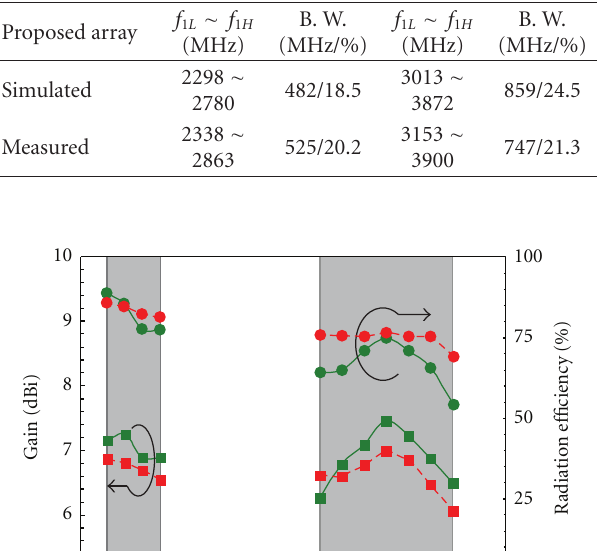
Table 1: Simulated and measured VSWR against frequency for the proposed planar dual-band dipole array with high-gain operation.